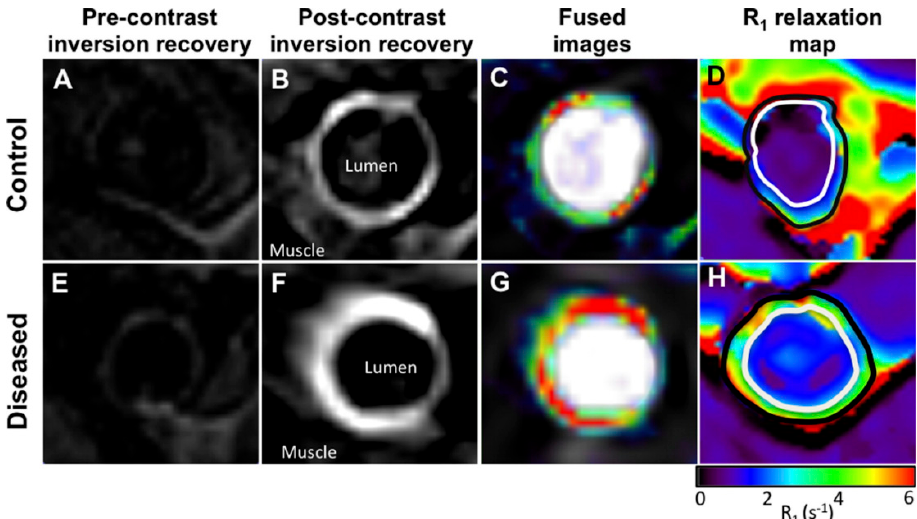
Figure 7. ( A , E ), Cross-sectional pre-contrast MR images. ( B , F ), Corresponding DE MR images obtained